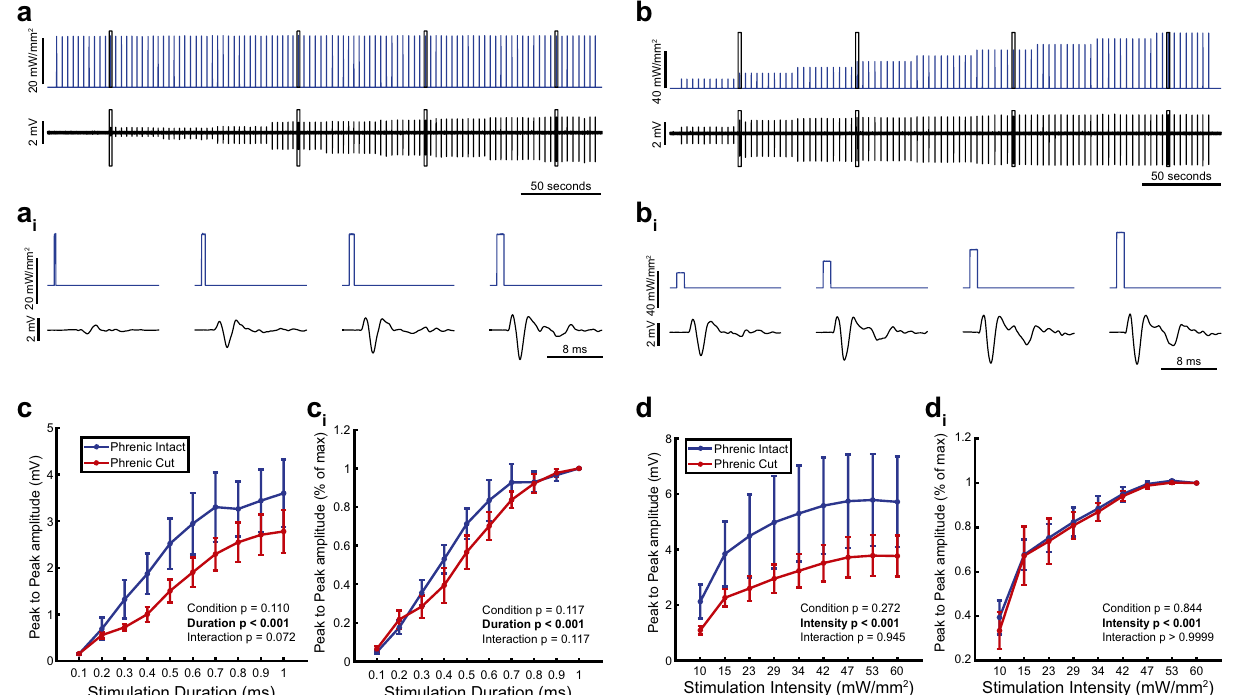
Figure 1. Diaphragm responses to single pulse photostimulation. The top panels show representative data traces from experiments in which pulse duration ( a ) or light intensity ( b ) were systematically varied. The expanded time scale traces shown in panels ( a i ) and ( b i ) allow viewing of evoked diaphragm EMG potentials. The average peak-to-peak amplitude of diaphragm evoked potentials in response to increasing pulse duration are shown in ( c ); average responses to increasing light intensity are shown in ( d ) (n = 4 per group). In both experiments, photostimulation was done before (blue) and after (red) unilateral phrenicotomy. Light stimulation was directed at the hemi-diaphragm ipsilateral to the phrenicotomy. Data are presented in absolute units (mV, panels c and d ) or normalized to the peak to peak amplitude response at maximum stimulus intensity (panels c i and d i ). Panel ( c) : 2-way RM ANOVA showed a significant effect of pulse duration ( p < 0.001). The trend for reduced amplitude after phrenicotomy was not statistically significant (condition p = 0.110), nor was the interaction between duration and condition ( p = 0.072). Panel ( c i ): 2-way RM ANOVA (square root transformed, non-transformed data plotted), significant effect of duration ( p < 0.001) but not condition ( p = 0.117) or interaction ( p = 0.117). Panel ( d ): 2-way RM ANOVA: significant effect of duration ( p < 0.001) and no effect of condition ( p = 0.272) or interaction ( p = 0.945). Panel ( d i ): 2-way RM ANOVA, significant effect of intensity ( p < 0.001) but not condition ( p = 0.844) or interaction ( p >